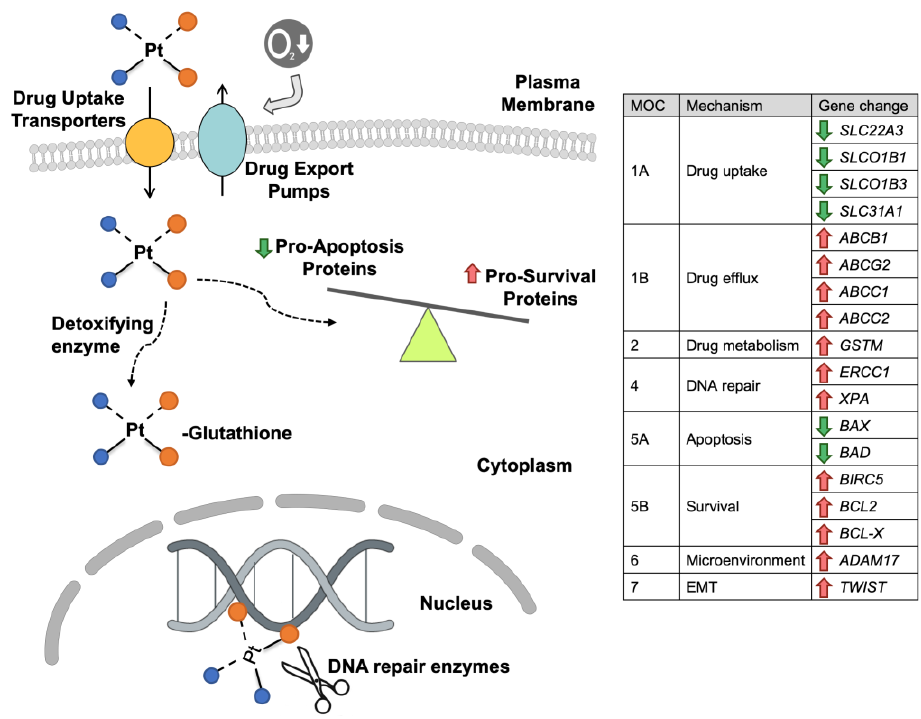
Figure 1. Schematic representation of mechanisms involved in chemoresistance (MOC) of hepatoblastoma to platinum derivatives. The table indicates the change in hepatoblastoma of the expression levels of genes involved in the chemoresistance to platinum derivatives: uptake transporters (MOC-1A), export pumps (MOC-1B), detoxifying enzymes (MOC-2), DNA repair enzymes (MOC-4), pro-apoptotic proteins (MOC-5A), anti-apoptotic proteins (MOC-5B), tumor cell microenvironment (MOC-6) and epithelial-mesenchymal transition (EMT) (MOC-7).